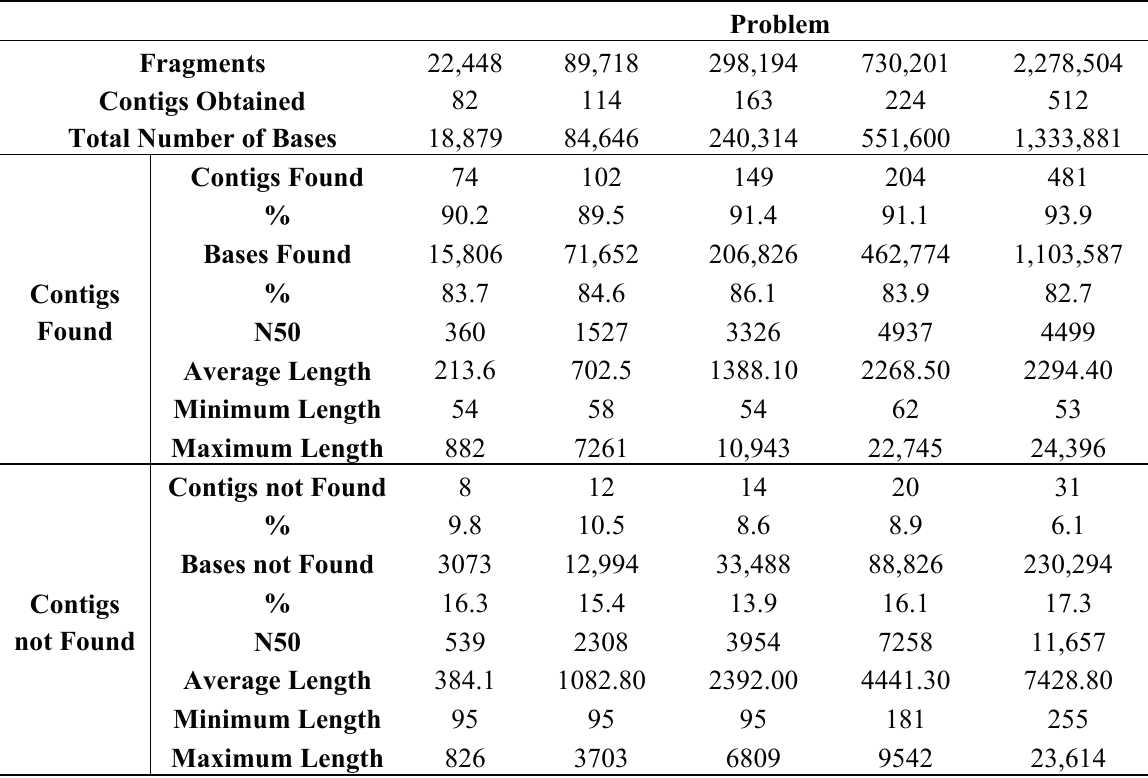
Table 8. Algorithm 1, F 1 objective function, no transitive